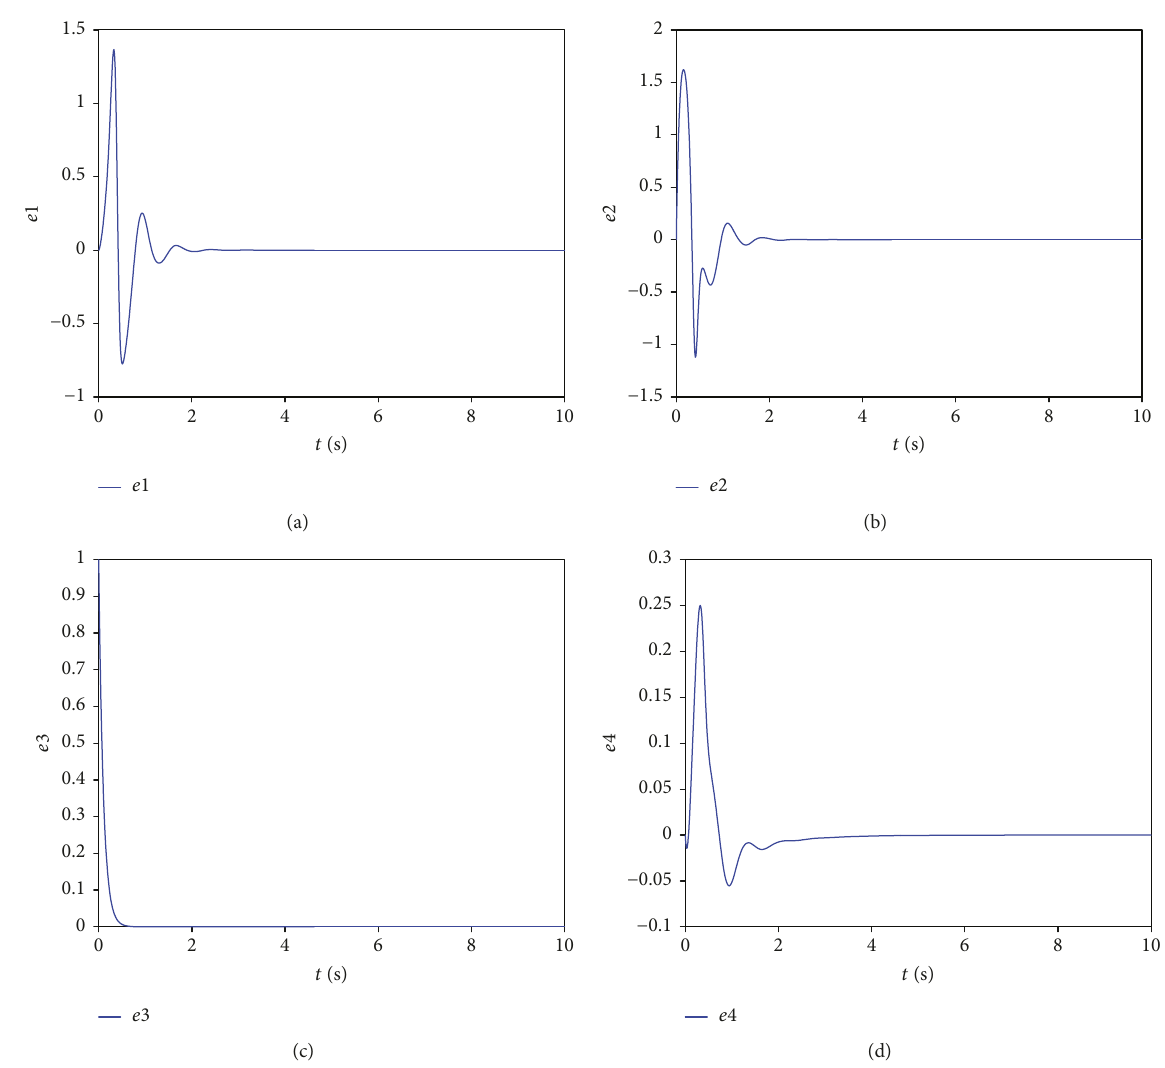
. (c) State trajectories of e 2